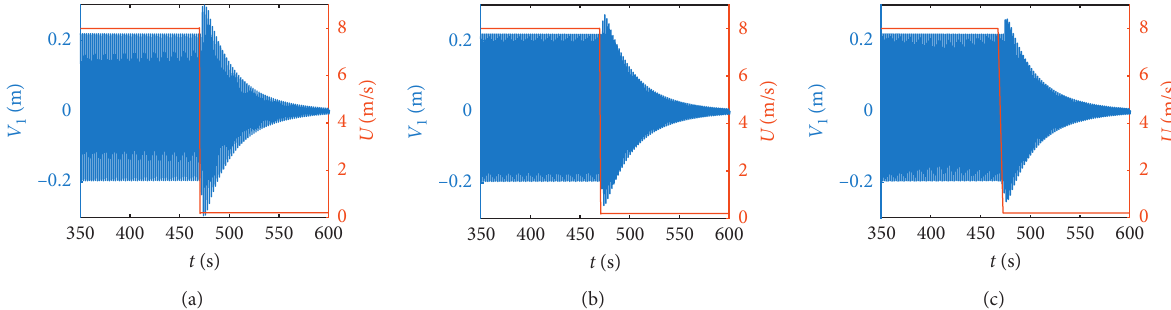
� 8 m/s and U � 0m/s. (a) t � 0.5s. (b) t � 2s. 1 2 d d